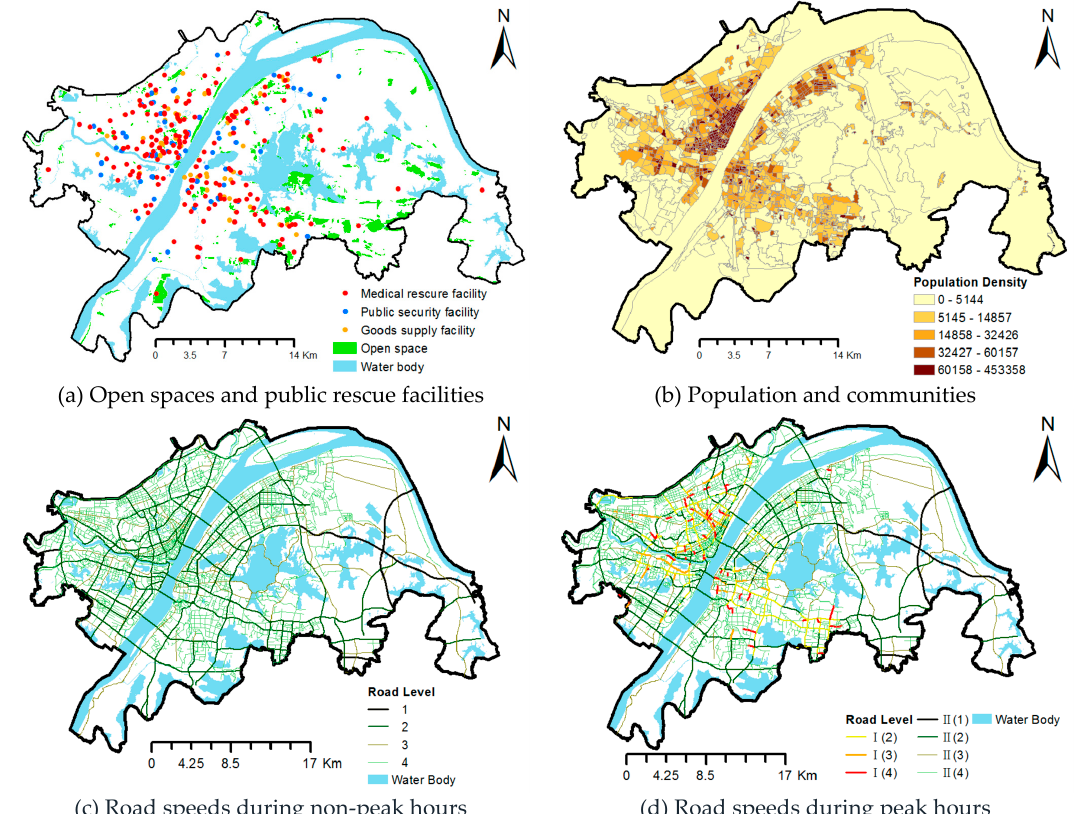
Figure 5. Spatial data utilized in the analysis. ( a ) Screened open spaces adopted and the distribution of public security, medical rescue, and goods supply facilities; ( b ) A total of 1071 communities with their population densities; ( c ) Road speeds during non-peak hours. The road levels represent different hierarchies; Level 4 denotes a paved road, Level 3 a branch road, Level 2 the general road, and Level 1 the main road; ( d ) Road speeds during peak hours. I represents blocked roads. II represents unobstructed roads. Road levels represent different hierarchies; Level 4 denotes paved roads, Level 3 branch roads, Level 2 the general road, and Level 1 the main road. Table 2. Road Types with Their Widths and Speed Limits (unit: km/h). Hierarchy Effective Width (m) Segments